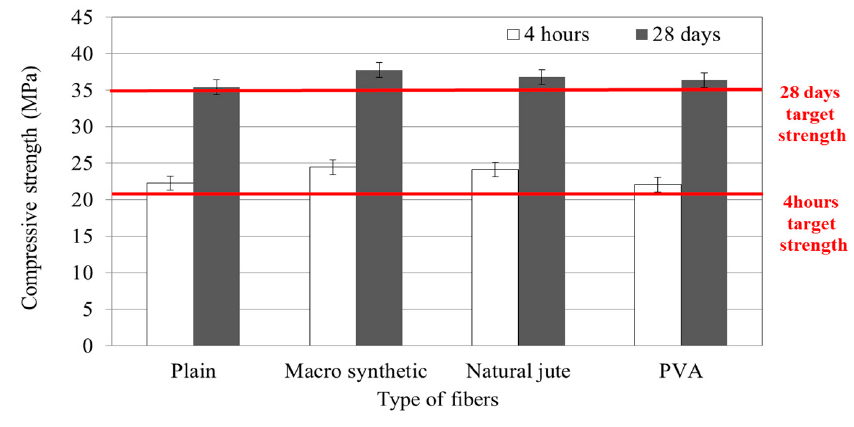
Figure 7. Compressive strength of RCLMFRRHCC.